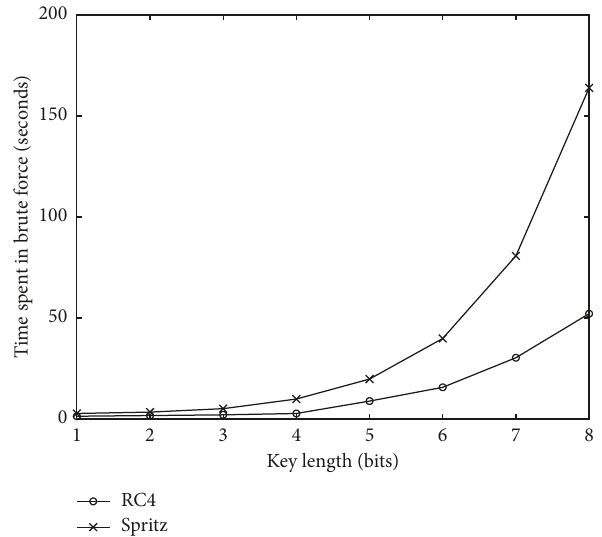
Figure 9: Plot of time taken for brute force for RC4 and Spritz.